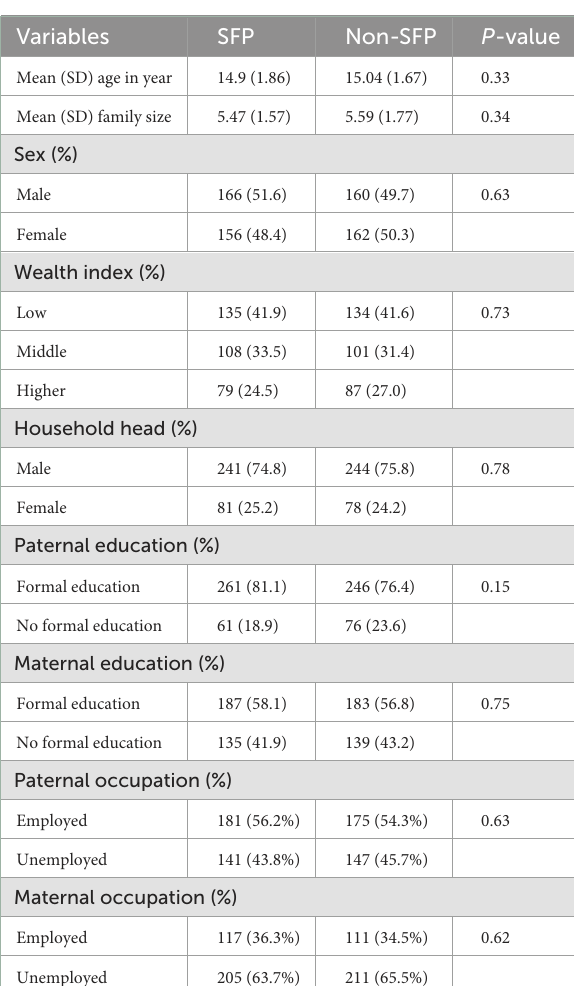
TABLE 1 Demographic and socio-economic characteristics of a cohort of primary school adolescents at baseline in Addis Ababa and Adama, Central Ethiopia in